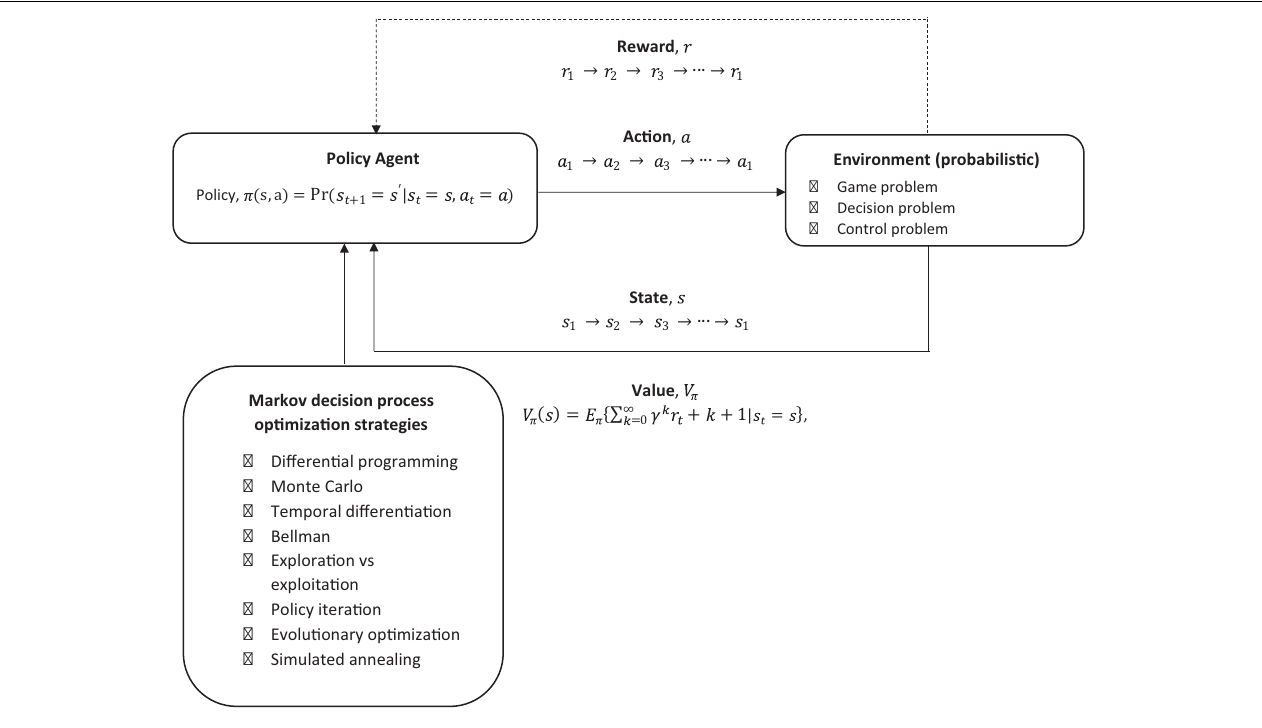
FIGURE 7 | Overview of reinforcement learning machine learning framework which models decision making within an environment of reward.